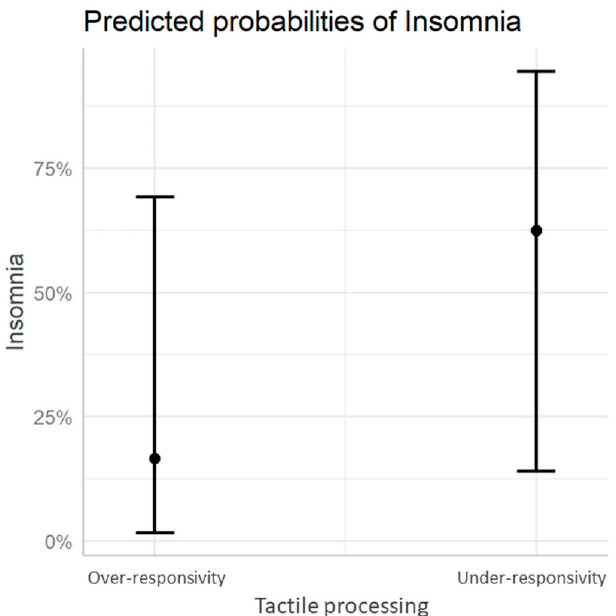
Figure 1. Insomnia Probabilities by TSM disorder, regarding age and gender of patients ( p = 0.23).